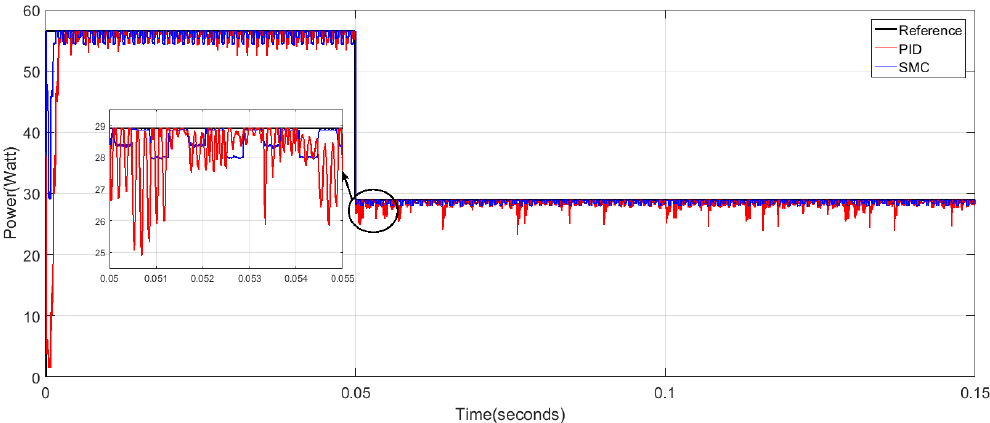
Figure 7. Reference, PID, and SMC PV voltage curve.